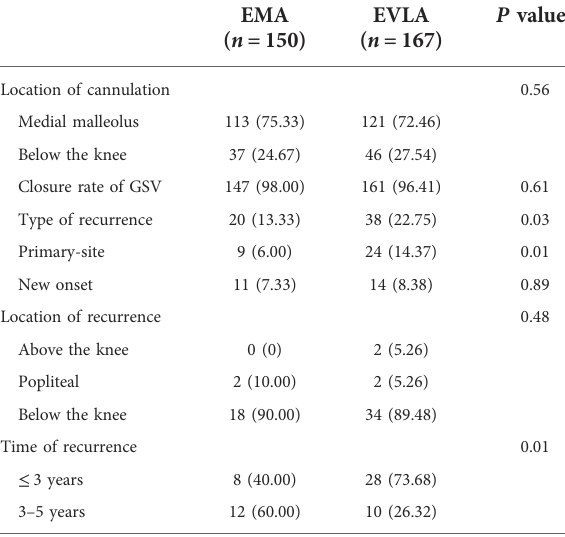
TABLE 2 The primary outcomes of the patients in both